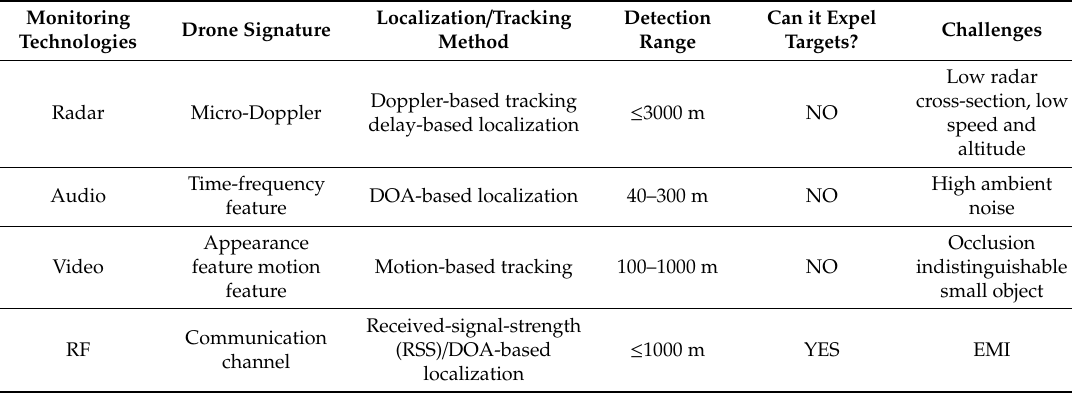
Table 1. Comparison of monitoring